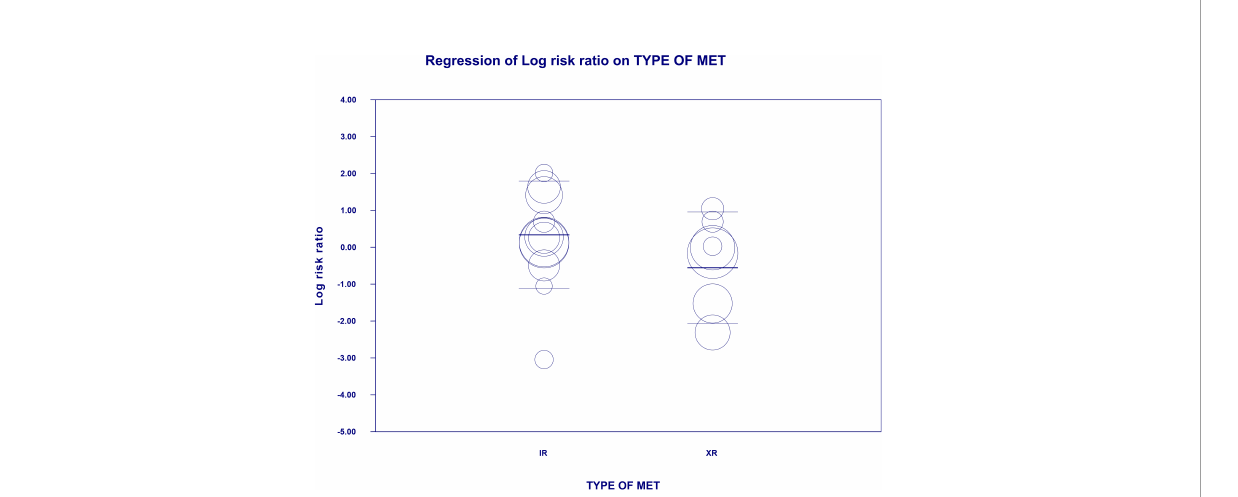
FIGURE 4 Regression for RR toward bloating by type of metformin. Each trial is represented by a circle, which size re fl ects the in fl uence of that study on the model (size is inversely proportional to the variance of study). Horizontal lines are estimates of the effect size and 95% con fi dence intervals. Risk ratio is showed on a logarithmic scale. XR, extended release; IR, immediate